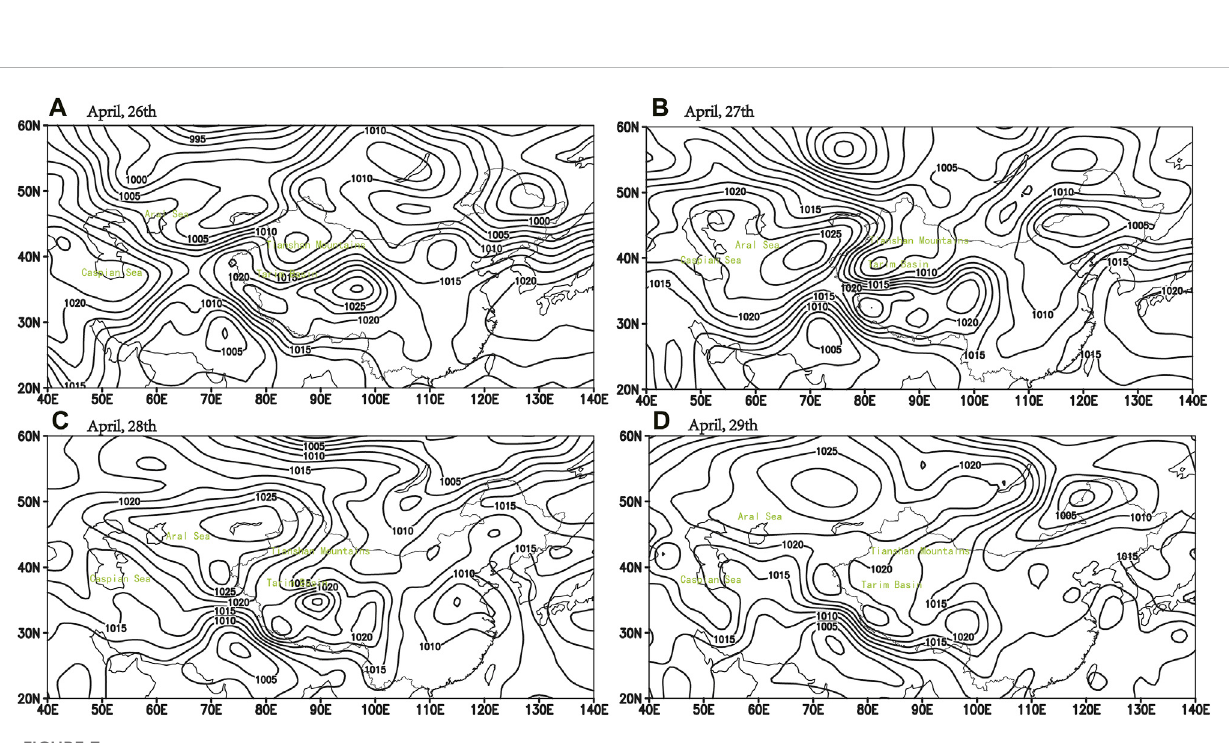
FIGURE 7 Sea-level pressure fi eld (contour lines, unit: hPa) during April 26 – 29, 2015 [ (A) April 26th; (B) April 27th; (C) April 28th; and (D) April